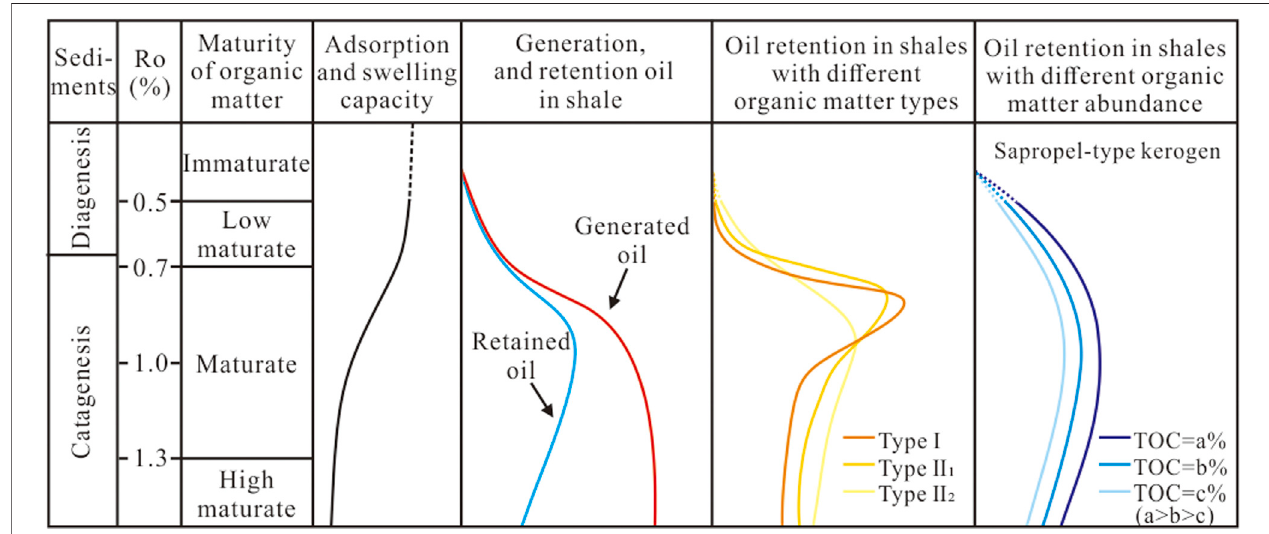
FIGURE 5 | Retention pattern of shale oil under different in fl uence factors (modi fi ed from Tian et al., 2014; Li J. et al., 2015; Li J. et al., 2018; Yang and Zou, 2019; Zhao X. Z. et al., 2020).